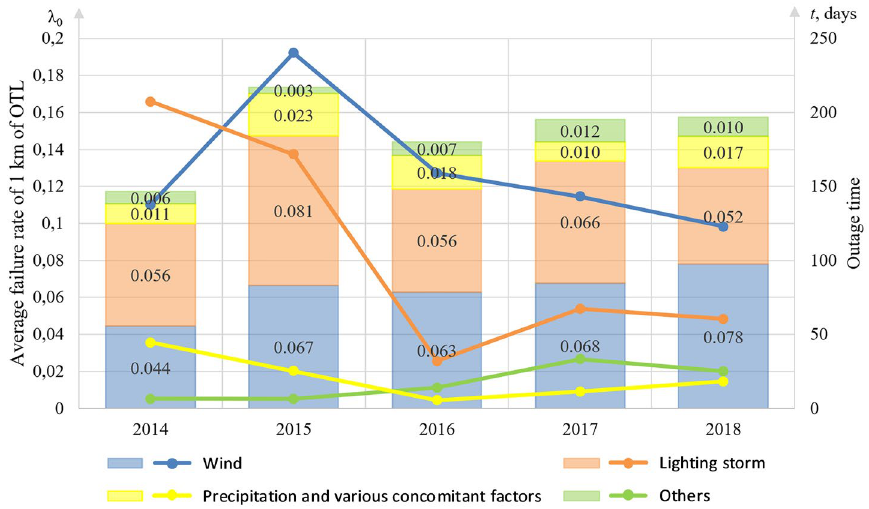
Fig. 3 The average failure rate of 1 km of OTL and OTL outage time (OOO Bashkirenergo) under the impact of the climatic factors from 2014 to 2018, where diagram area and curve are blue for wind, orange for lighting storm, yellow for precipitation and various concomitant factors, green for others climatic